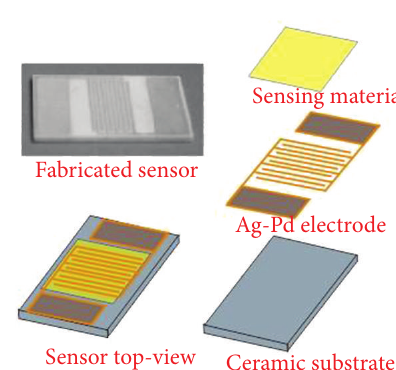
Figure 1: Structure representation of the fabricated gas